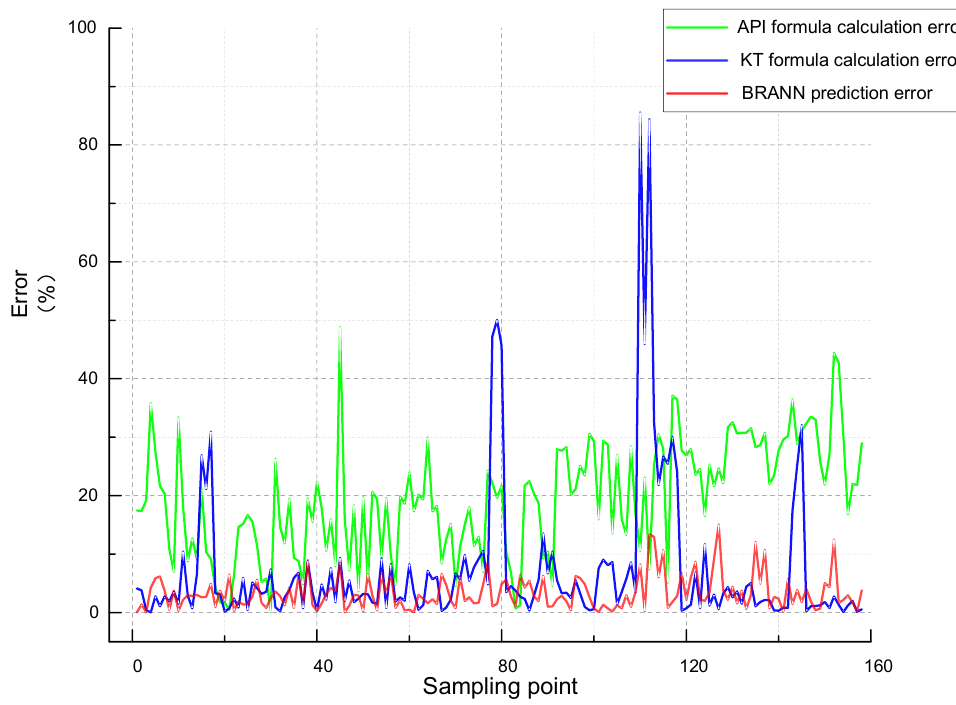
Figure 11. Comparison of prediction errors of collapse strength.